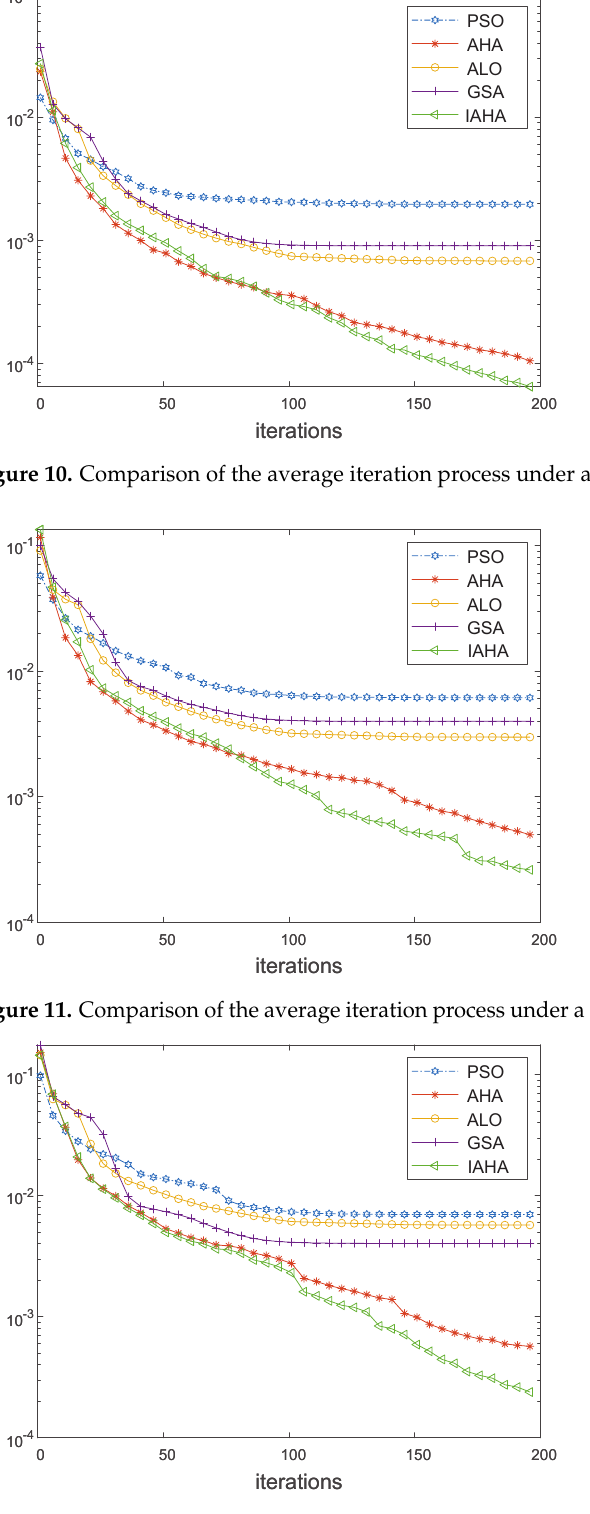
Figure 12. Comparison of the average iteration process under a 15% frequency disturbance